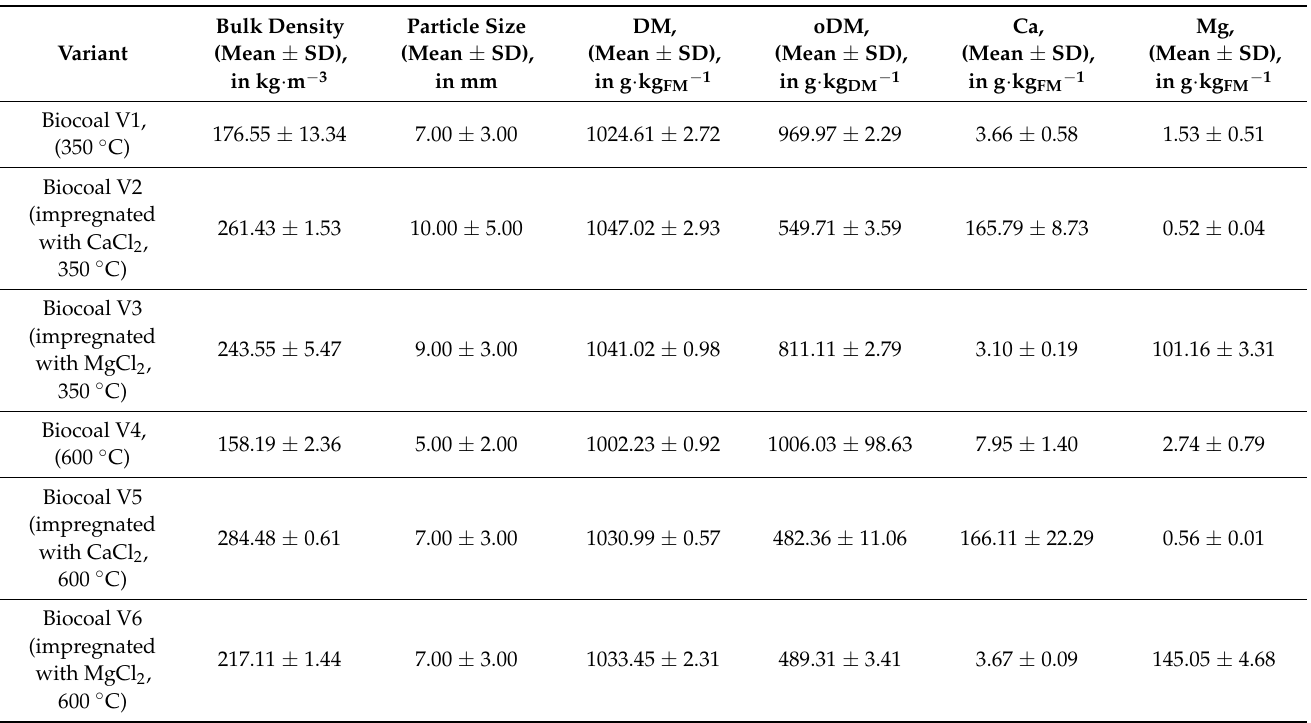
Table 4. Laboratory analyses of the